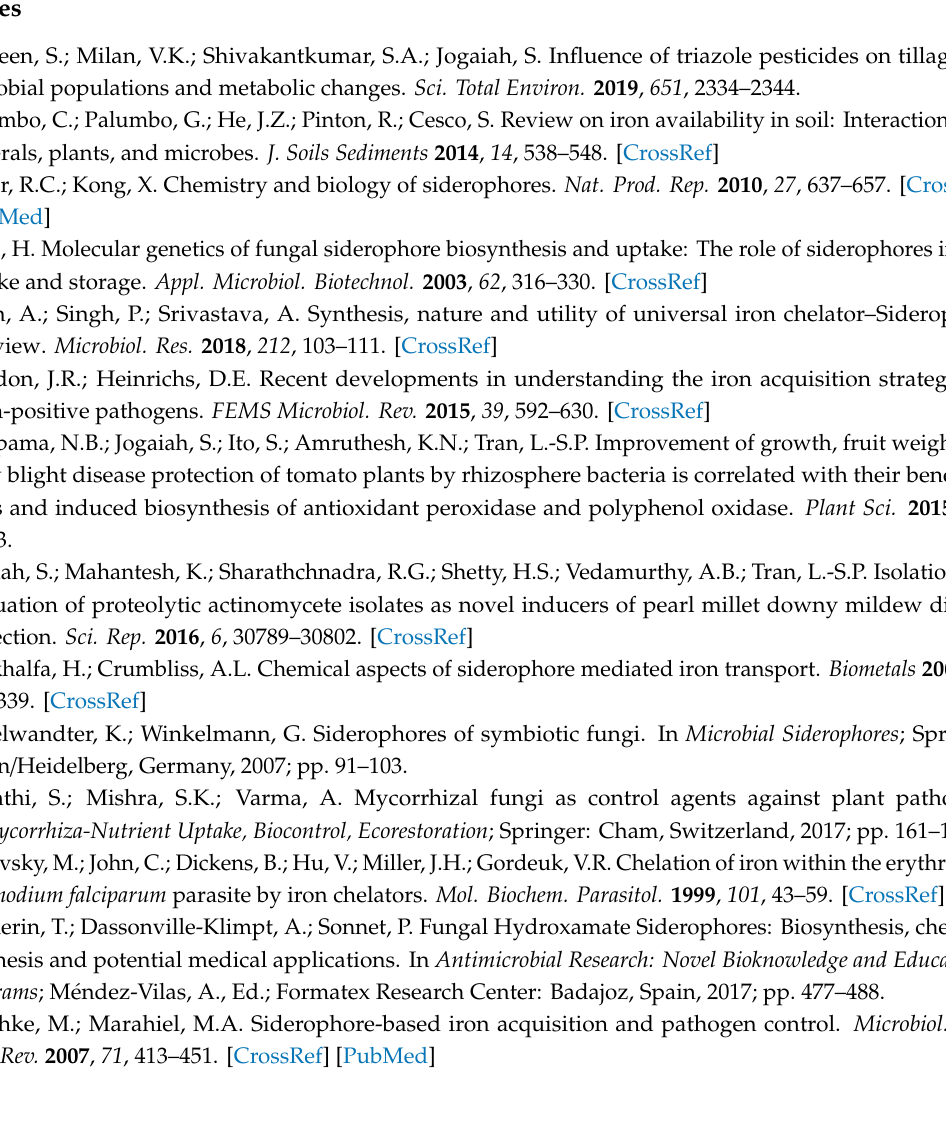
Figure S5. Agar well di ff usion of crude and purified siderophore extract by P. chrysogenum (CAL1) expressing clear orange halo zone on Chrome Azurol S agar medium. Figure S6. Purified siderophore extracted by P. chrysogenum (CAL1) showing formation of wine coloured spot on thin layer